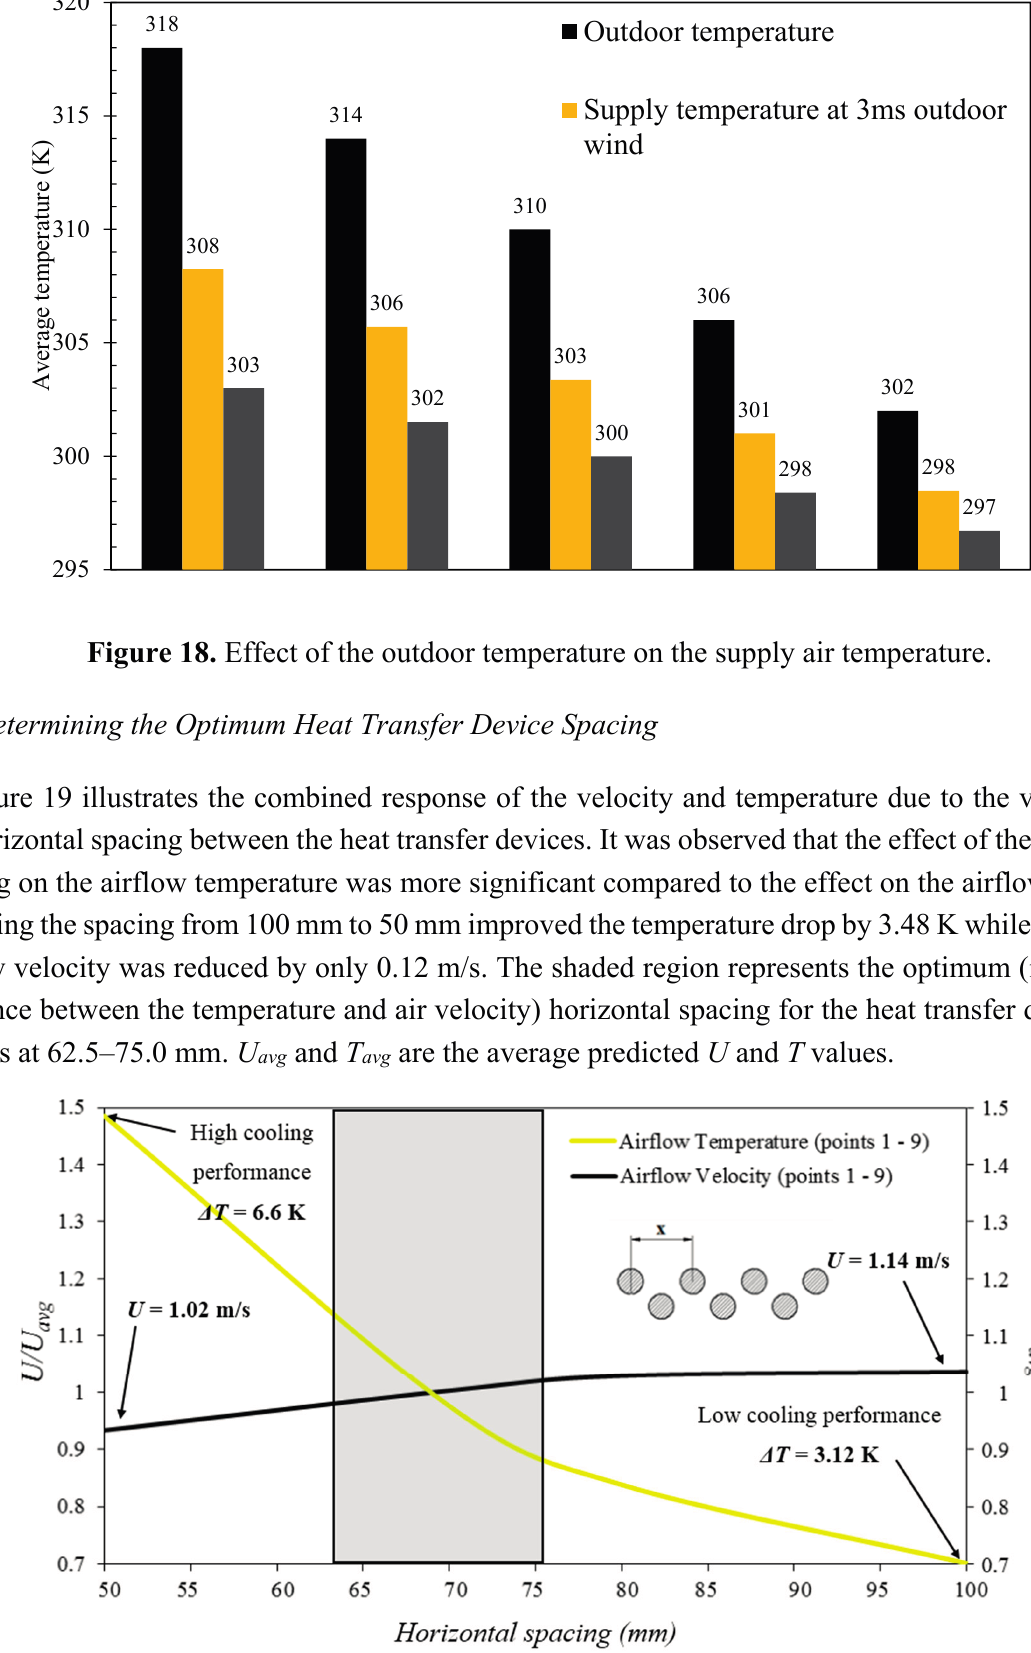
Figure 19. Effect of varying the horizontal spacing on the ventilation and thermal